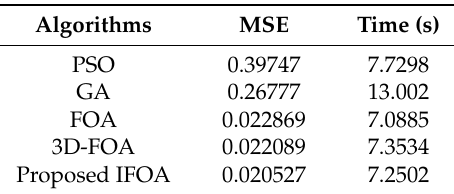
Table 3. Parameters.